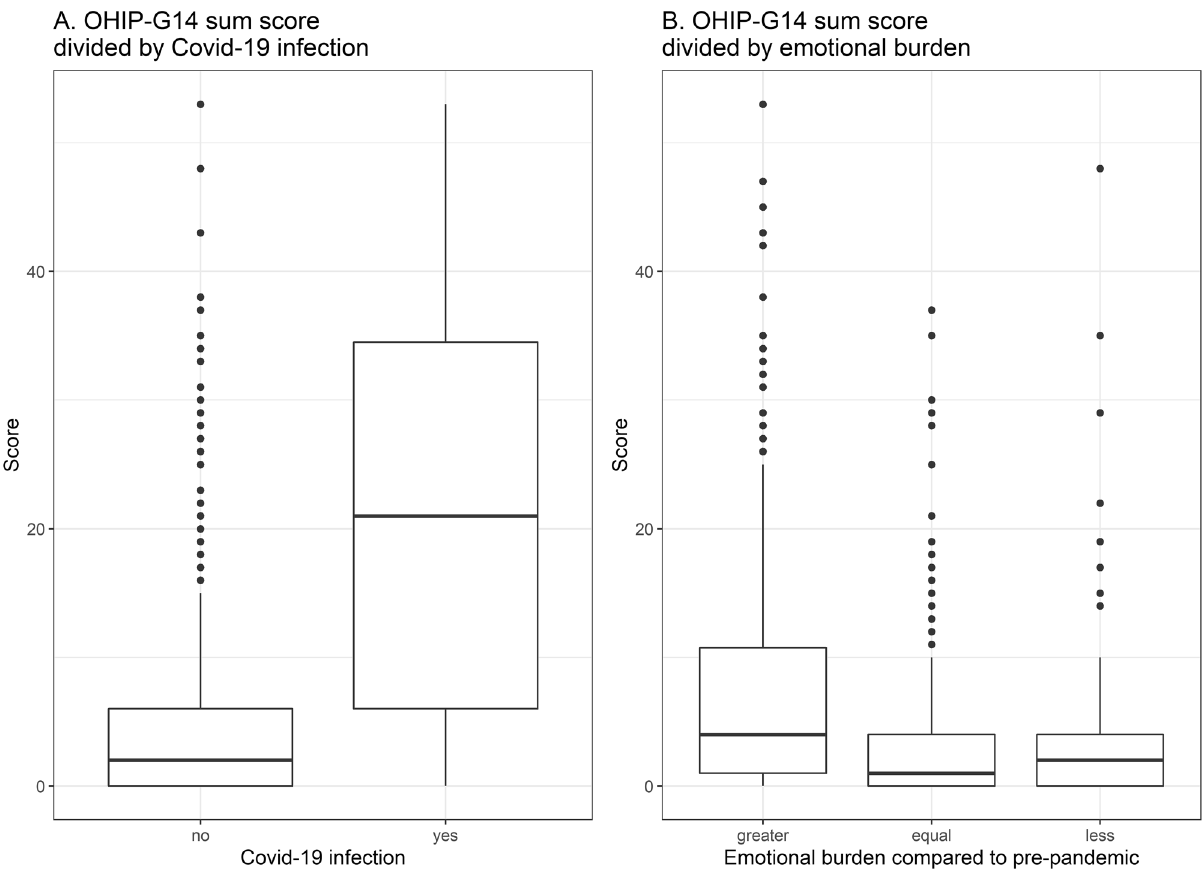
Figure 1. OHIP-G14 sum score stratified to participants with and without COVID-19 history ( A ) and greater, equal or less emotional burden compared to pre-pandemic ( B